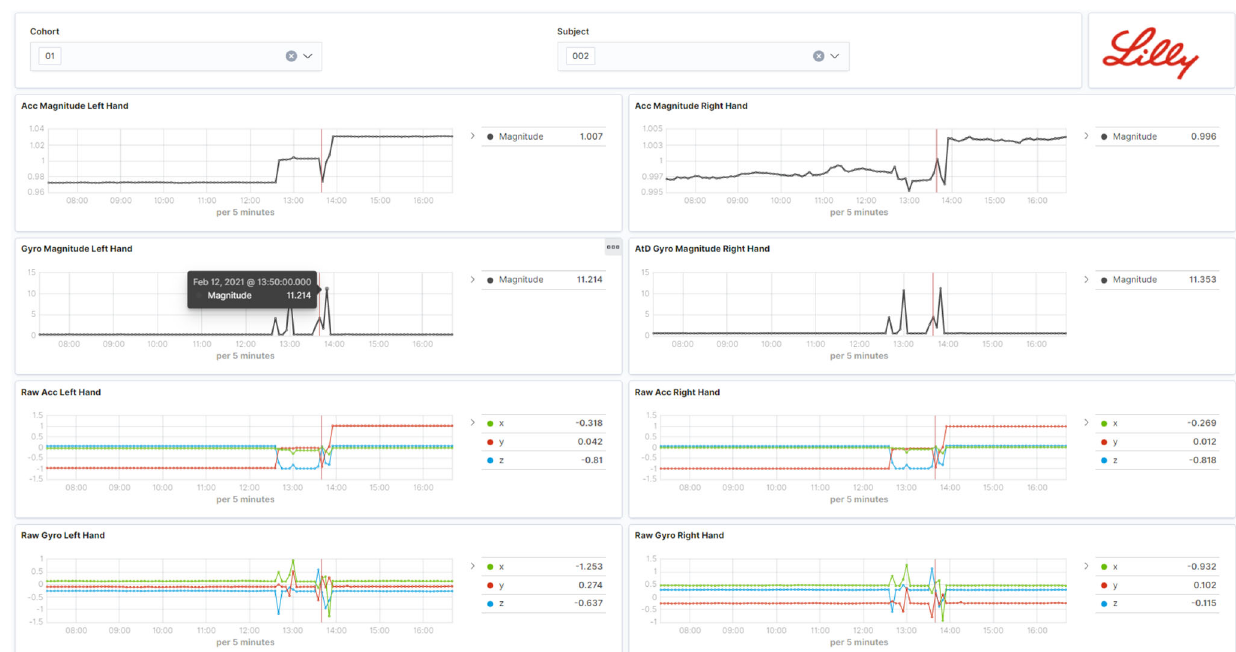
Fig. 10 An example of data visualization. Raw accelerometer and gyroscope sensor signals and their derived magnitudes of each participant ’ s hand are displayed and can be interactively